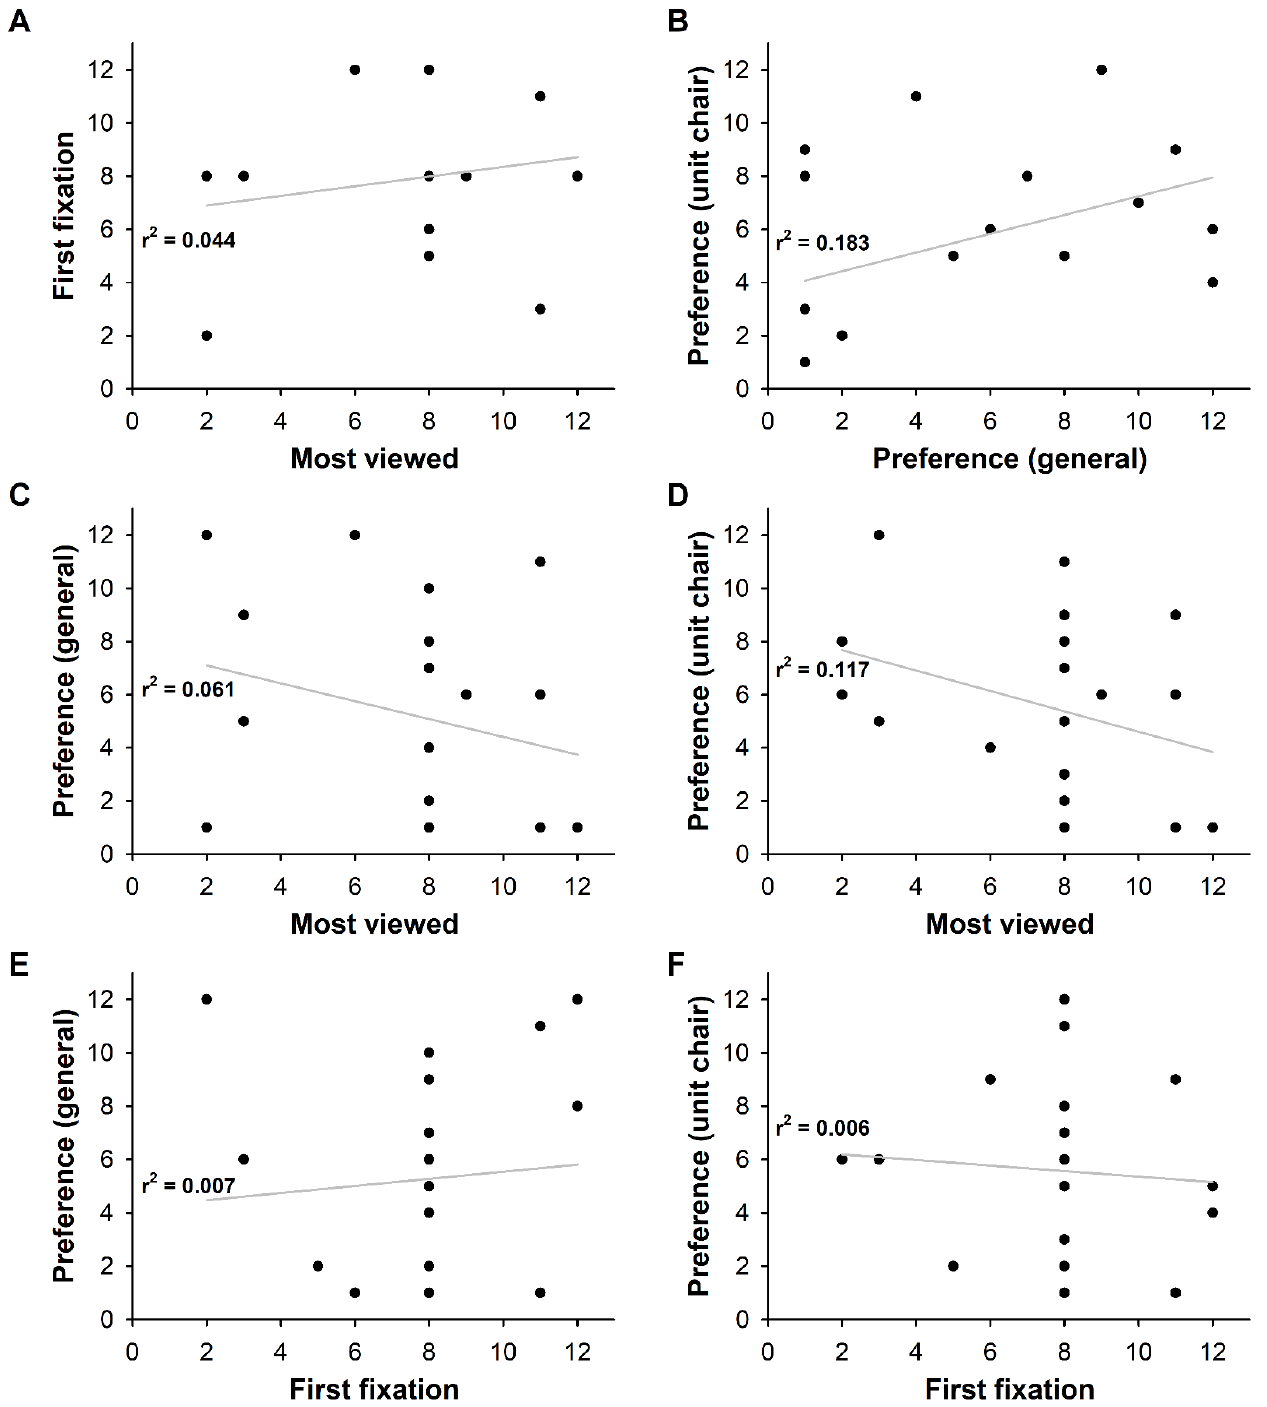
Figure 6. Correlation analysis for eye tracking and color preference. 1: sky blue, 2: light pink, 3: blue, 4: light green, 5: red, 6: brown, 7: orange, 8: pink, 9: green, 10: light yellow, 11: yellow, 12: purple. ( A ) Correlation between most viewed and